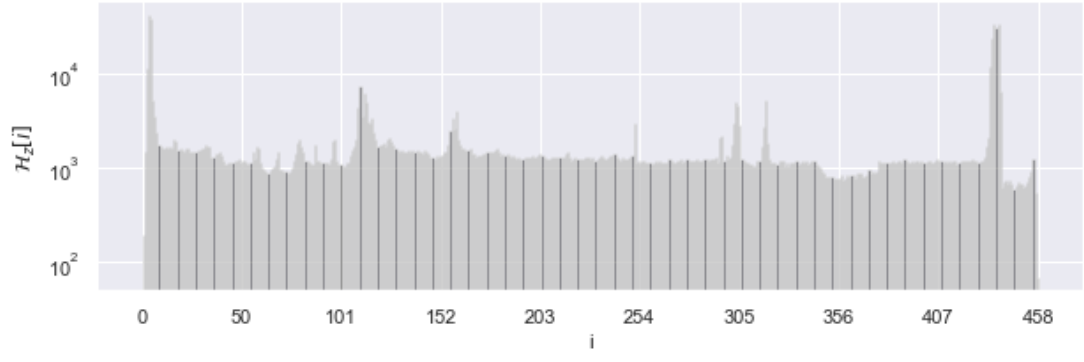
Figure 5. An example of a histogram for the OZ